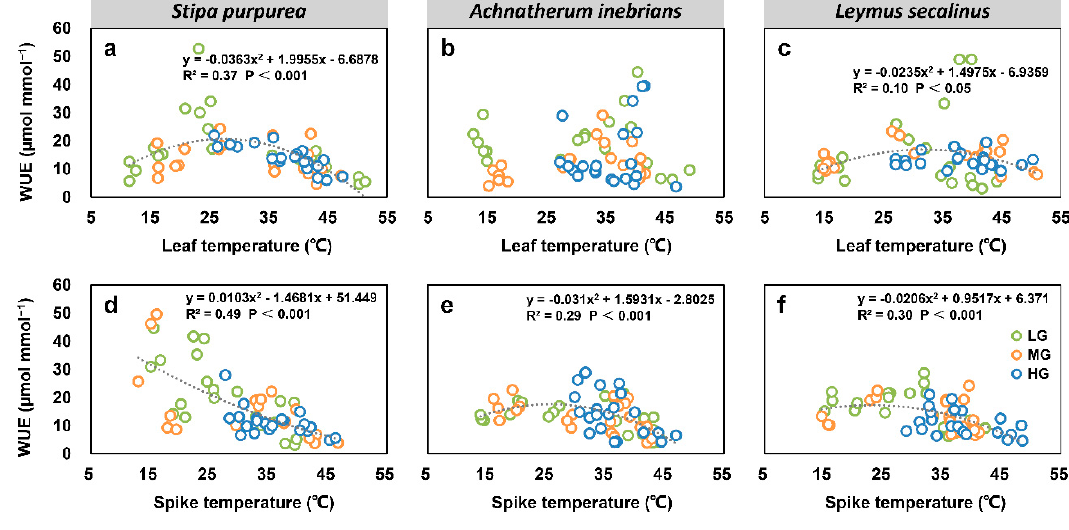
Figure 10. Correlations between leaf water use efficiency (WUE) and leaf temperature (T l ) (top), and between spike WUE and spike temperature (T s ) (bottom) of S. purpurea ( a , d ), A. inebrians ( b , e ) and L. secalinus ( c , f ) under grazing intensity (LG, light grazing; MG, medium grazing; HG, heavy grazing).